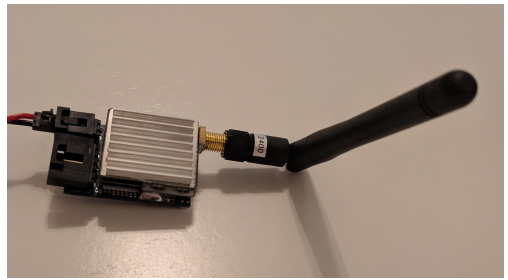
Figure 3. Boscam-TS321 2.4 GHz video transmitter.